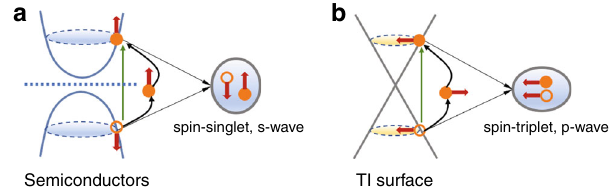
Fig. 1 Schematic plot of the direct interband optical absorption process. a The s -wave excitons are formed in the conventional semiconductors. b The helical spin texture of topological insulator (TI) surface state favors p -wave rather than s -wave